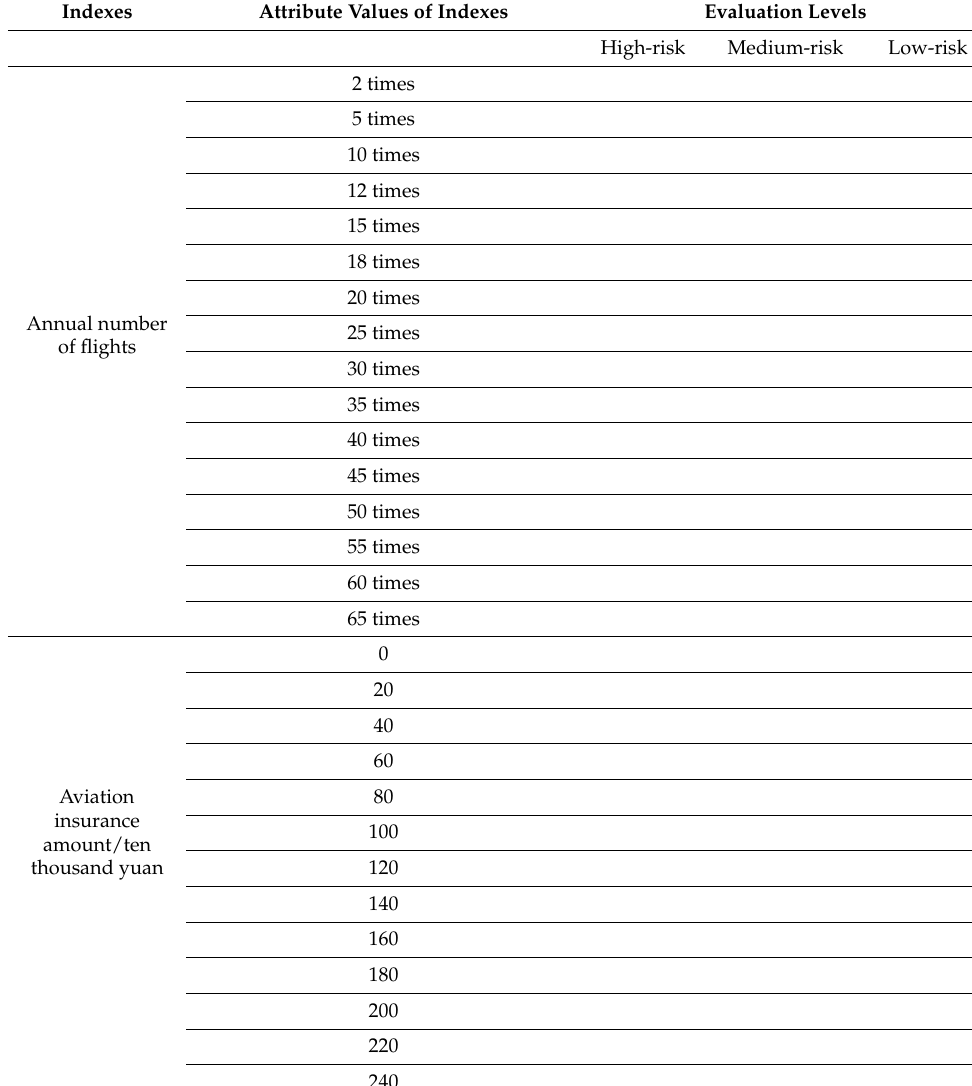
Table A11. Single factor evaluation of civil aviation travel record